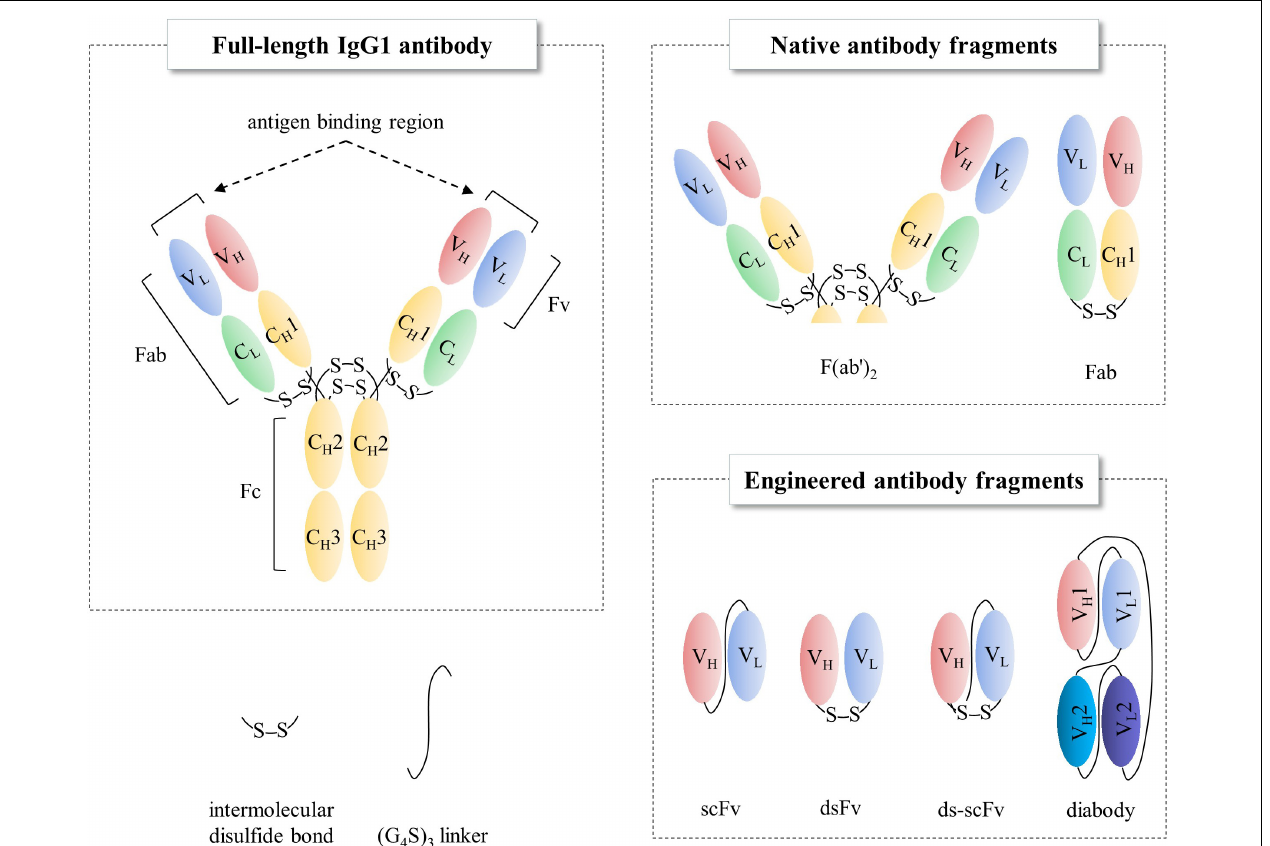
FIGURE 1 | Schematic representations of full-length IgG1 antibody and antibody fragments. Fab, fragment antigen binding; Fv, fragment variable; Fc, fragment crystallizable; scFv, single-chain Fv; dsFv, disulfide-stabilized